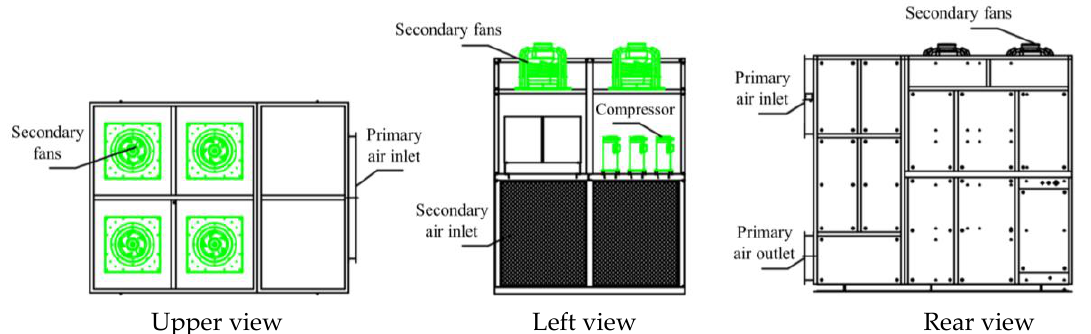
Figure 1. Physical schematic of the unit.